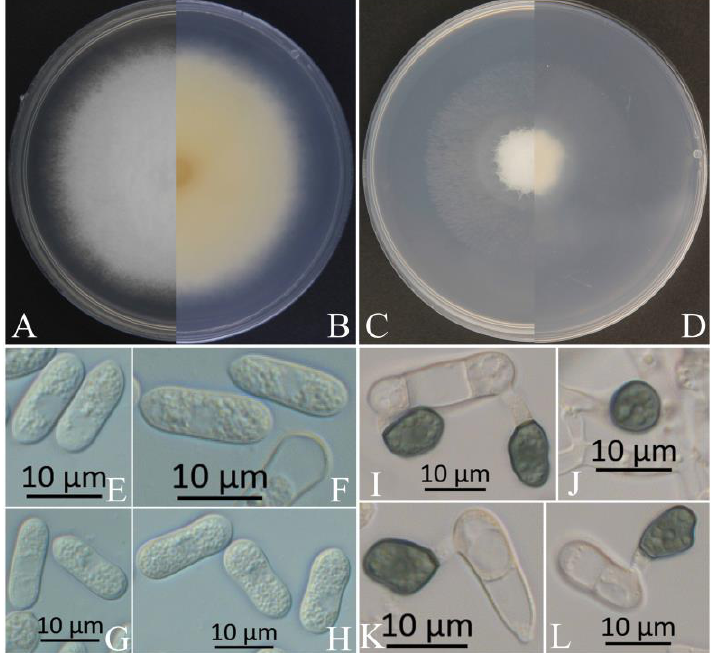
Figure 4. Morphological characteristics of XZEC31. ( A , B ) Front and reverse views of 4-day-old fungus on PDA, respectively. ( C , D ) Front and reverse views of 4-day-old fungus on SNA, respectively. ( E – H ) Conidia. ( I – L ) Appressoria. Scale bars: ( E – L ) = 10 μm.